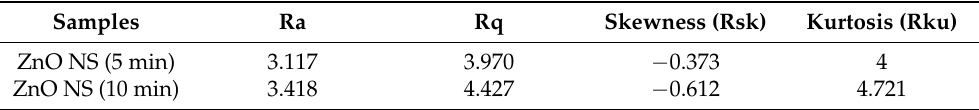
Figure 6. 3D AFM analysis images of the ZnO NS on which the H 2 reduction process was performed for five minutes ( a ) and 10 min ( b ).